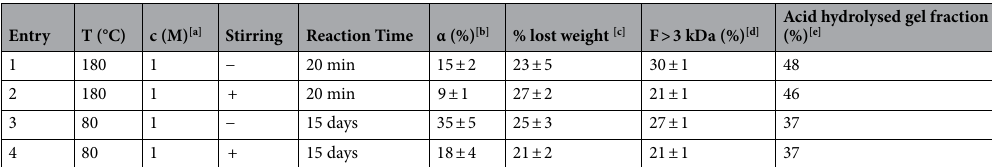
Table 2. Reactions were carried out to simulate alkaline hydrothermal systems under subaerial conditions (MWR, 180 °C, entries 1 and 2) and under aerial environments (CTS, 80 °C, entries 3 and 4). All reactions were carried out under an inert nitrogen atmosphere. [a] Initial concentrations of NaCN and NH 4 Cl (equimolar) in aqueous solutions. [b] α (%) = conversion degree for the gel fractions [α (%) = [(mg of gel fractions)/(initial mg of CN - )] * 100]. Note the greater amount for the insoluble solids obtained from the no-stirring experiments. The values of α (%) obtained herein are in strong agreement with previous results 20,49 . [c] % lost weight = [(initial mg of NaCN + mg NH 4 Cl)-(mg of freeze-dried sol fractions + mg gel fraction)/(initial mg of NaCN + mg NH 4 Cl)] *100. The lost weights (likely due the loss of NH 3 and other volatiles during the polymerization processes) are similar in all cases. [d] F > 3 kDa (%) = [(mg of F > 3 kDa)/(mg of freeze-dried sol fractions)] *100. The F > 3 kDa (%) is lower for the stirring experiments, as in the cases for the α (%), which seems to indicate that the stirring of the systems decreases the production of heavier macromolecular fractions. [e] % of the gel fraction susceptible to acid hydrolysis. Acid hydrolysed gel fraction (%) = (mg of soluble supernatant after acid hydrolysis of the gel fraction/mg of gel fraction)*100. These percentages are in good agreement with those previously reported 20 . At least three independent experiments were carried out for each experimental condition to calculate the average values shown in this table and to check the reproducibility of the cyanide polymerization